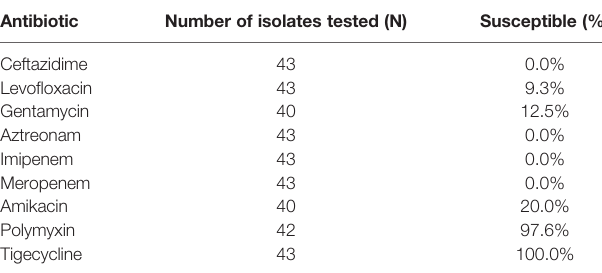
TABLE 3 | Antimicrobial susceptibility of isolates from patients with carbapenem-resistant klebsiella pneumoniae infection. Antibiotic Number of isolates tested